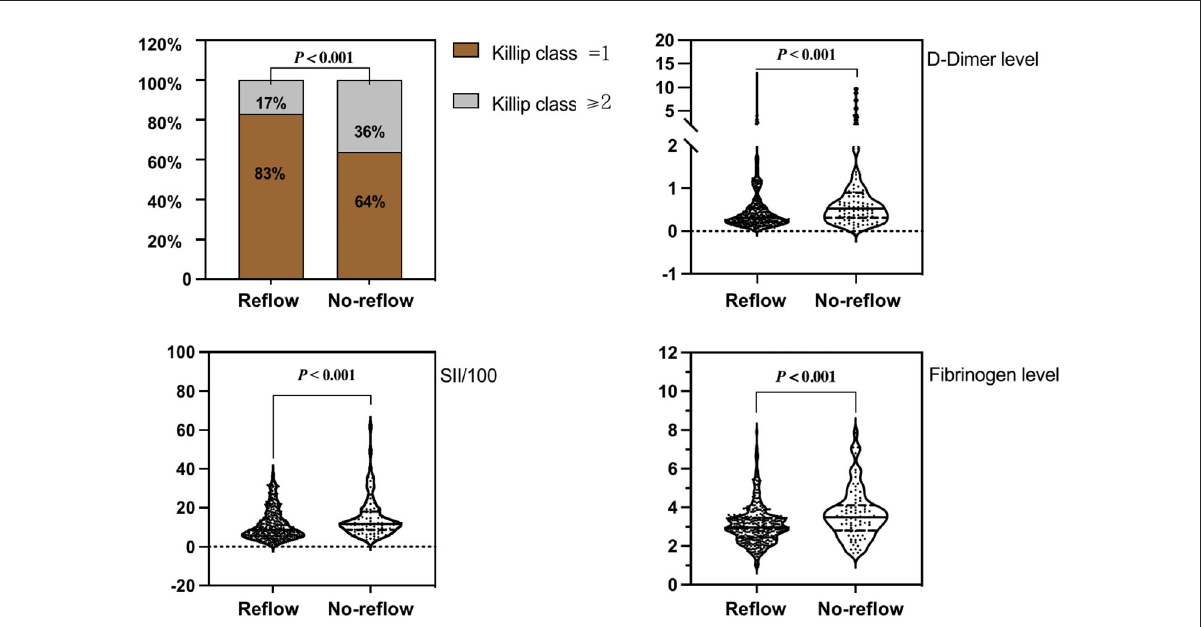
FIGURE1 Comparison of Killip class on admission, D-dimer level, fibrinogen level, and SII/100 values between groups.